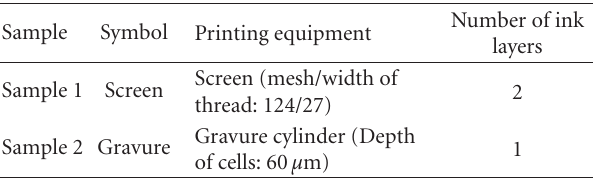
Table 4. Screen-printed samples were produced by printing two layers of ink. The ink layer was cured after the second printing. Rotogravure silver ink was diluted with n- Propylacetate before gravure